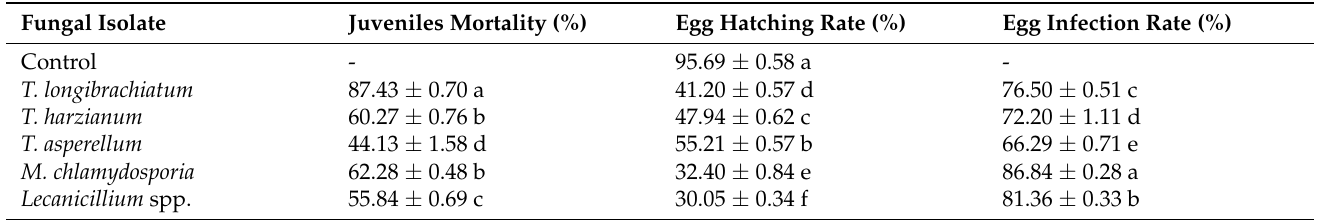
Table 1. Effects of the nematophagous fungi on M. javanica juveniles mortality, egg hatching, and egg infection rate.